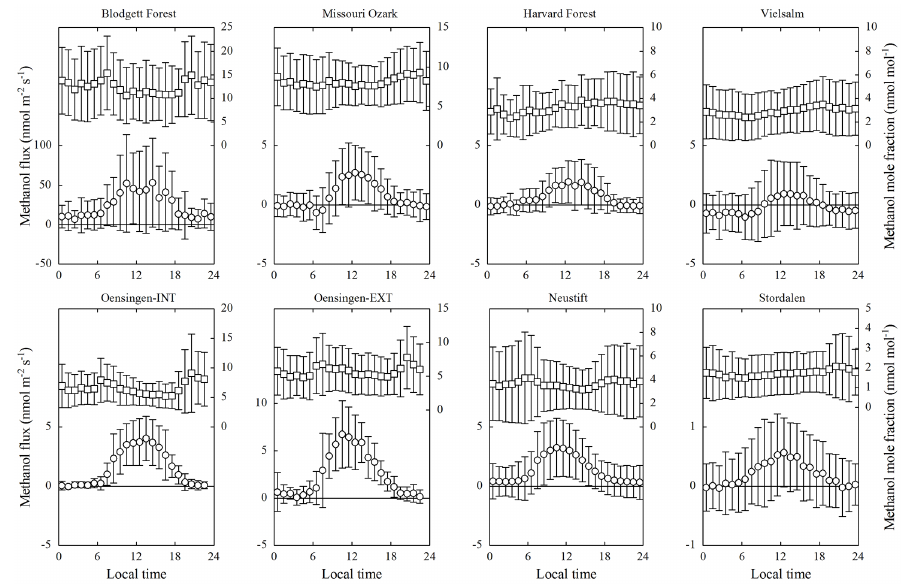
Figure 1. Hourly bin-averaged diurnal variation of methanol fluxes (circles; left y axis) and mole fractions (squares; right y axis) at the eight study sites (error bars represent ± 1 standard deviation). Note the differing scaling on the y axis. Data from Oensingen-INT, Oensingen-EXT and Neustift are exclusive of periods influenced by management practices.